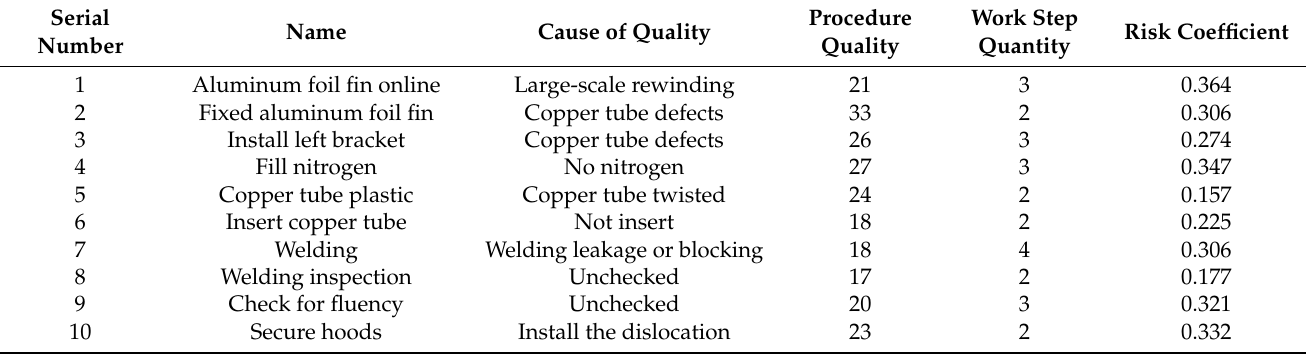
Table 3. Procedure requirements and data related to the product manufacturing